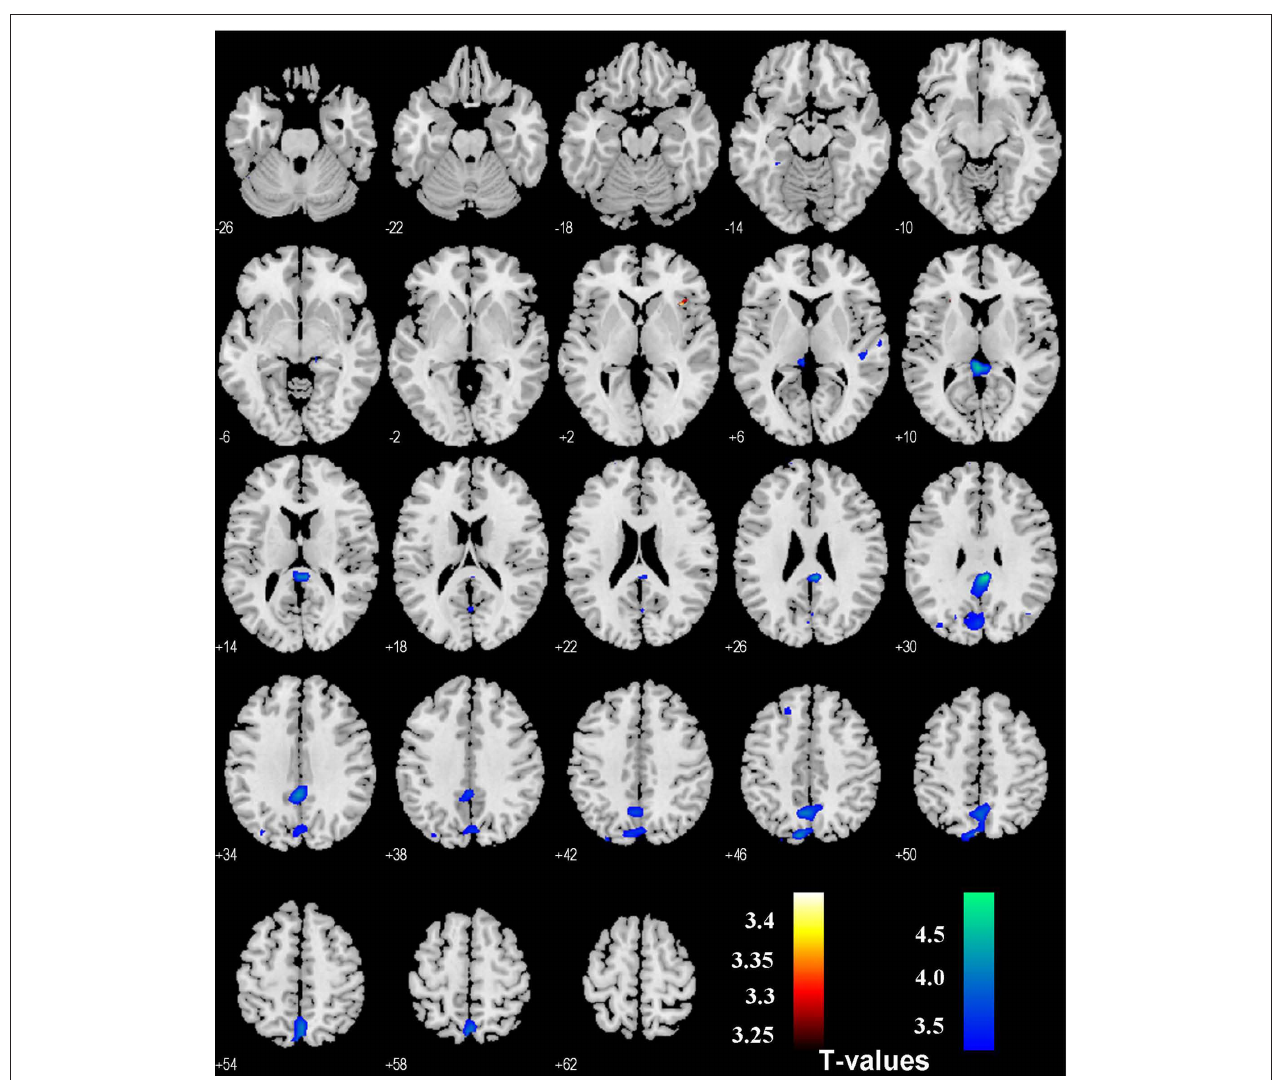
FIgure 4 | regions showing psychophysiological interaction with the habenula during stop success (SS) as compared to go success (g, in hot color), and during g > SS (in cold color) in the stop signal task. T maps were thresholded at p < 0.001, uncorrected.